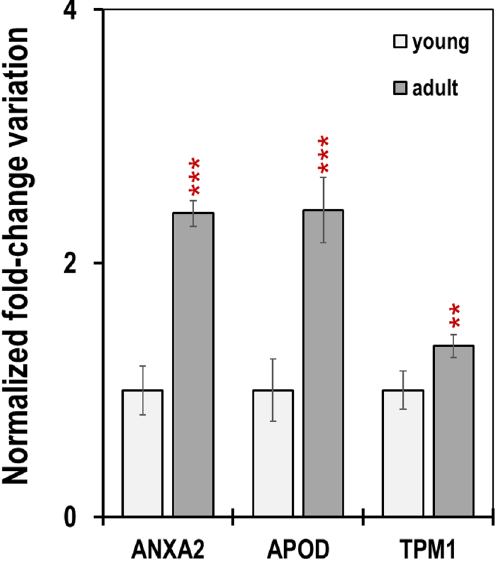
Figure 6. Normalized fold change variation in the expression level of ANXA2, APOD and TPM1 in the antler blood (mean ± SEM, n = 5 and n = 10 in the young and adult groups, respectively). The relative mRNA levels of three target genes, normalized with the geometric means of the abundance of the most stable reference genes B2M, ACTB and RPLP0. Statistical significance is expressed as: * p < 0.05, ** p < 0.01 vs. control (young